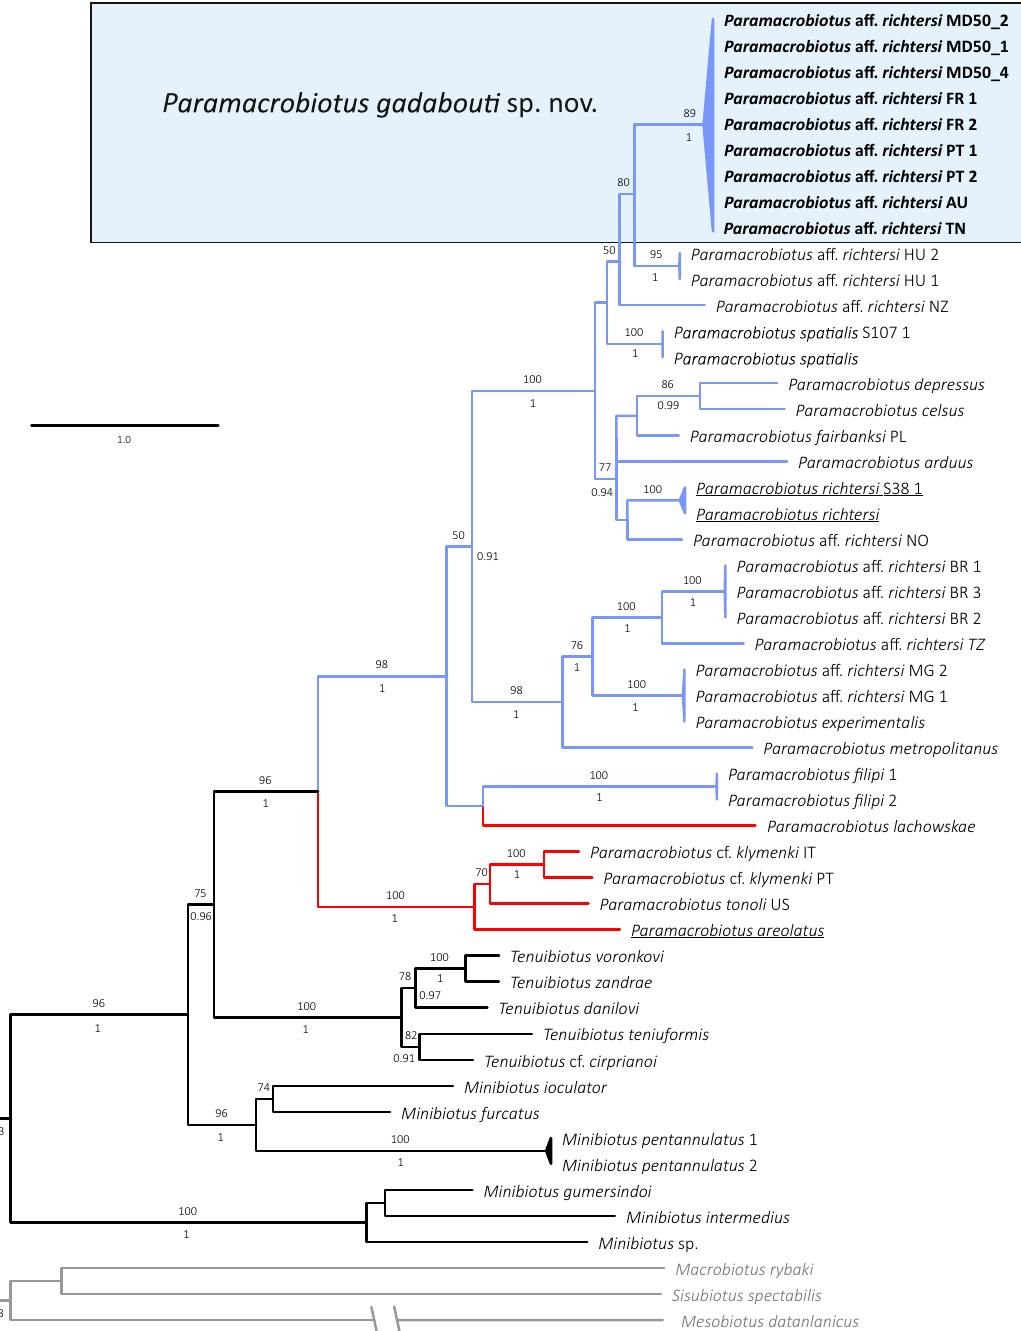
Figure 1. Maximum likelihood (ML) phylogeny constructed from concatenated sequences of the family Macrobiotidae (18S rRNA + 28S rRNA + ITS-2 + COI; Table 1). Numbers above branches indicate bootstrap support values, while Bayesian posterior probabilities (pp) are given below branches. Bootstrap < 50 and pp < 0.90 are not shown. Taxa of the Pam. richtersi and Pam. areolatus complex are indicated by blue and red branches, respectively. The outgroup is indicated in gray font. The scale bar represents substitutions per